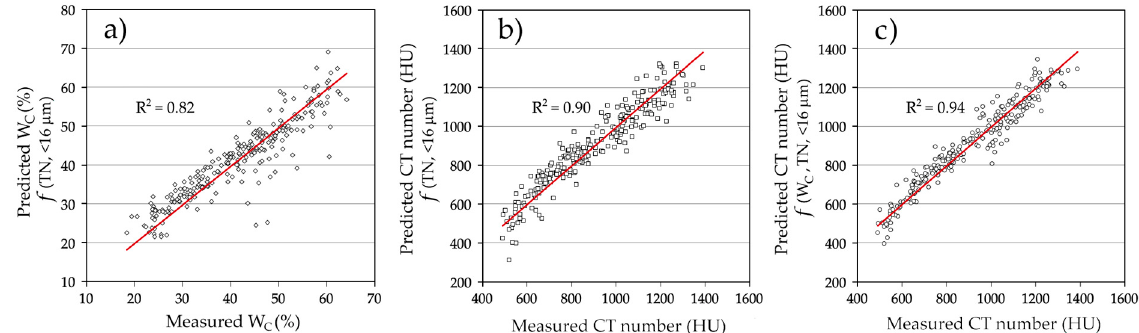
Figure 7. Plots of measured versus predicted values with multiple linear regression models. Variables used in regression models ( a ), ( b ) and ( c ) are indicated on y -axis. R 2 is the determination coefficient of linear fit forced to pass through origin. Model parameters are shown in Table 3.